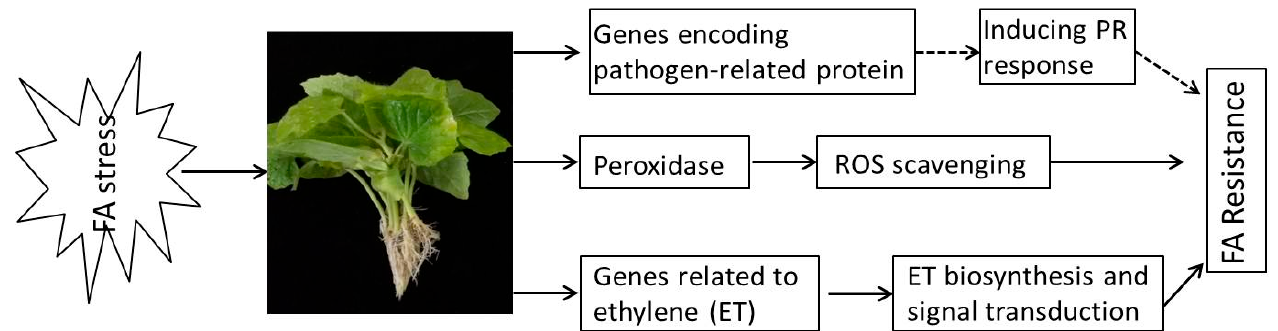
Figure 8. A model for the mechanism of FA resistance in chieh-qua. Under FA stress, ‘A39’ exhibited enhanced resistance compared with ‘H5’ due to induction of genes encoding pathogen-related protein and ET biosynthesis and signal transduction. Also, increased expression of peroxidase and SOD activity would improve ROS scavenging ability, reducing stress effects.